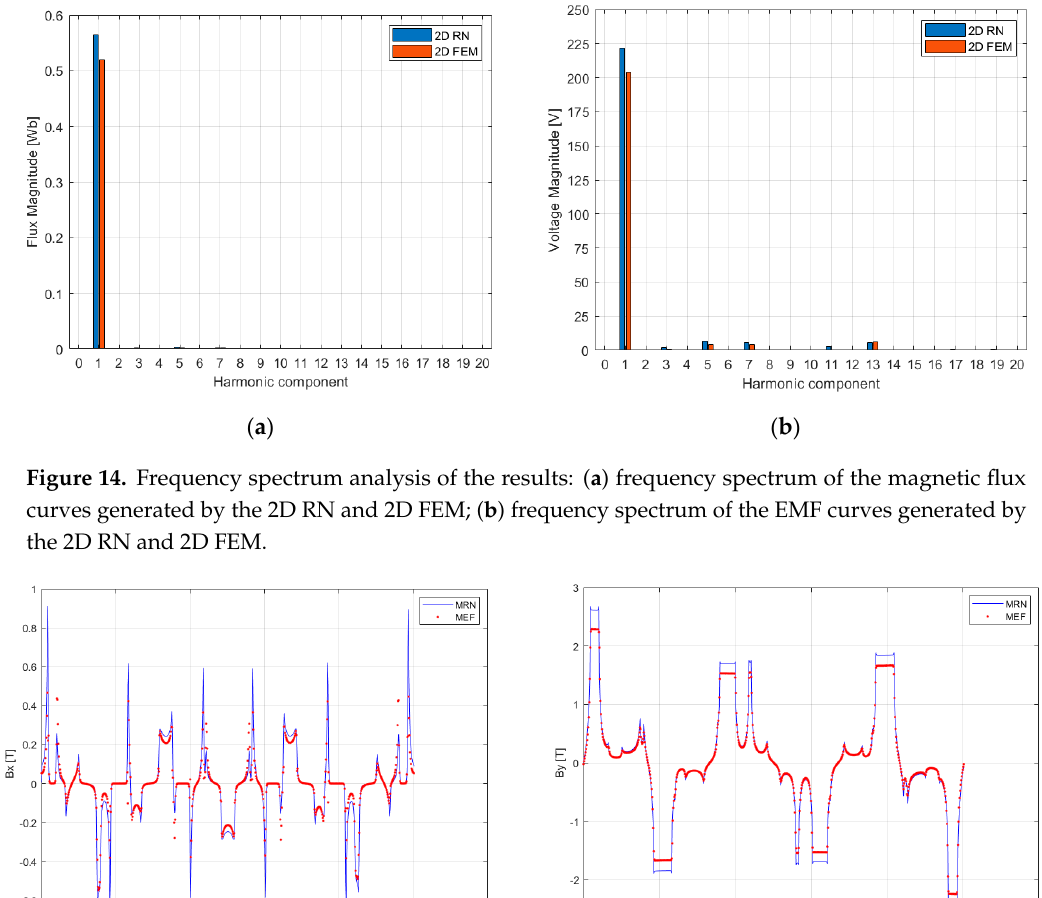
Figure 13. Comparison between the results from the 2D RN and 2D FEM: ( a ) total Magnetic flux per phase; ( b ) voltage EMF per phase considering the machine running at 375 rpm.